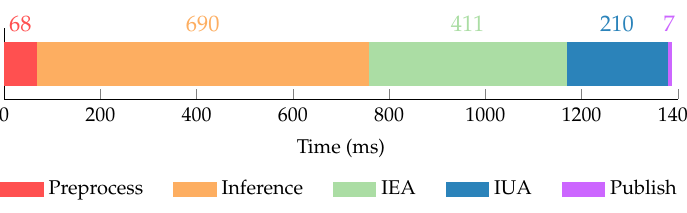
Figure 15. Online execution time